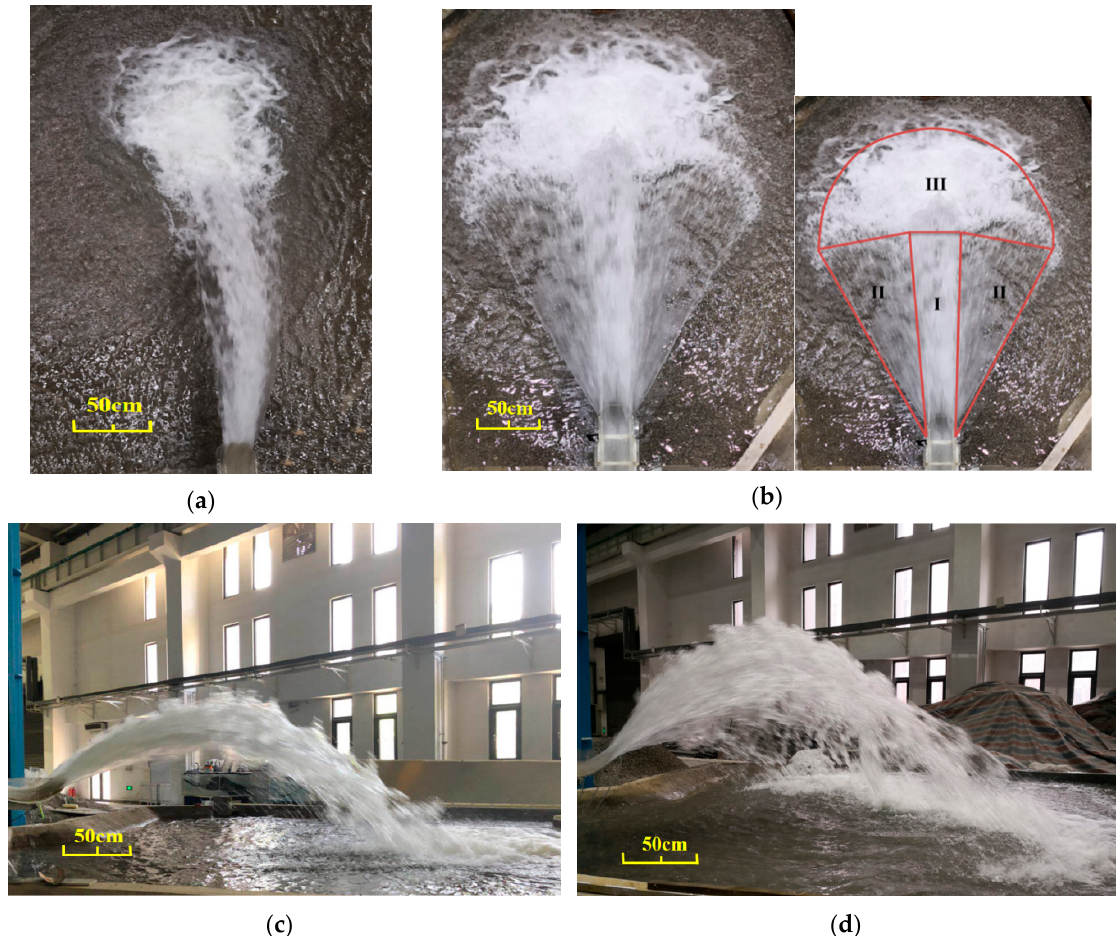
Figure 4. Photographs of the flow regime of the trajectory nappe under the same flow conditions (bucket angle: 50°): (a) the top view of the CB, (b) the top view of the TB, (c) the side view of the CB, and (d) the side view of the TB. Int. J. Environ. Res. Public Health 2019 , 16 , x